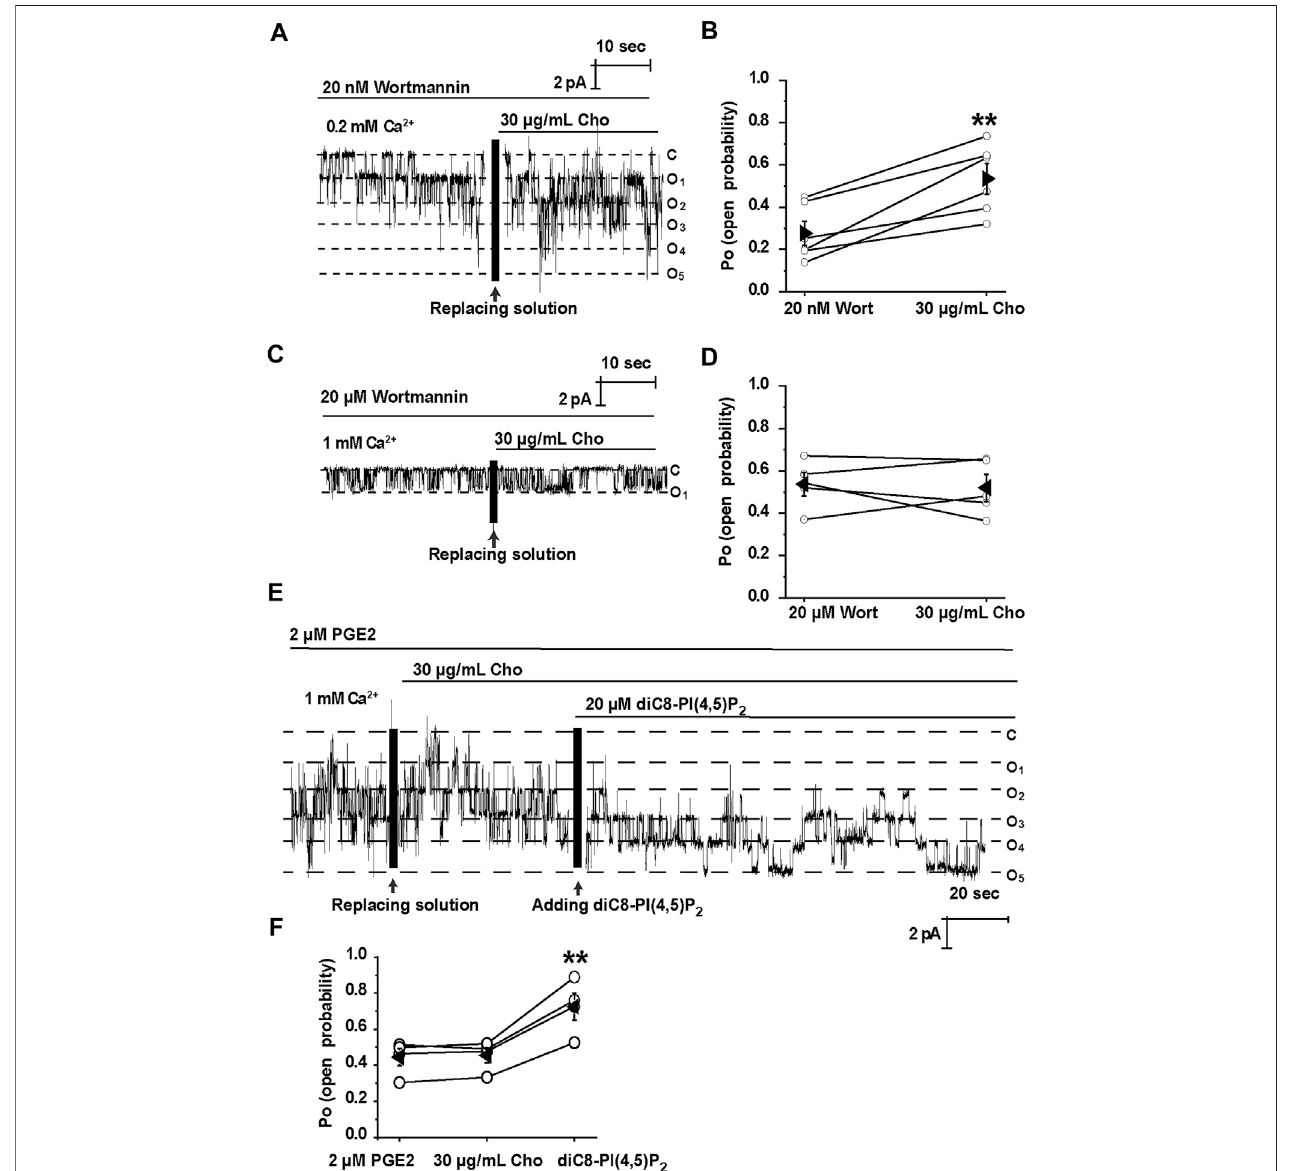
FIGURE 4 | Cholesterol stimulates TRPM4 via a PI(4, 5)P 2 -dependent mechanism. (A) A representative single channel recording shows that treatment of